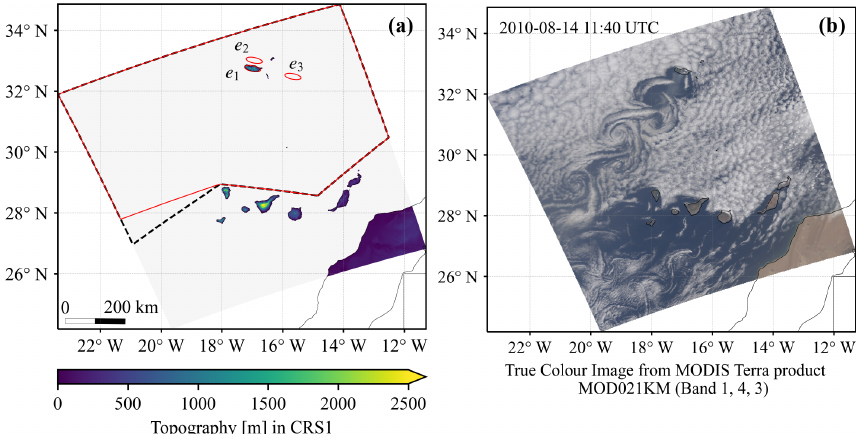
Figure 2. (a) The grey shading shows the region used for subsequent analysis. The red ellipses e 2 and e 3 were obtained by shifting e 1 as defined in Fig. 1b along its minor and major axes to extract upstream and undisturbed flow conditions, respectively. The dashed black and red polygons were used for vortex identification in Sect. 2.4. (b) An example of vortex streets to the lee of Madeira is visible through stratocumulus clouds using the data product MOD021KM from the MODIS Terra satellite (Savtchenko et al., 2004). Such pictures can be viewed directly on the website of NASA Worldview (https://worldview.earthdata.nasa.gov, last access: 30 January 2023). The geographic map is from Natural